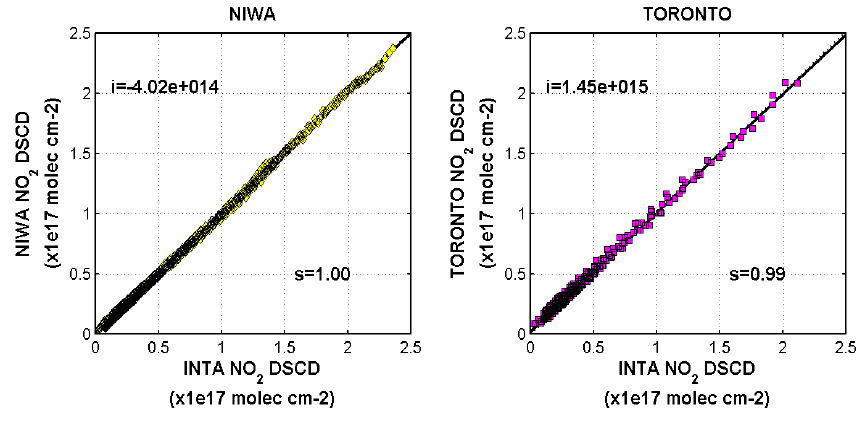
Fig. 15. Straight line fits of zenith sky measurements of NIWA and Toronto to those of INTA interpolated to the measurement time of NIWA and Toronto respectively. These are fits to twilight data from the whole campaign, hence the large density of measurements.